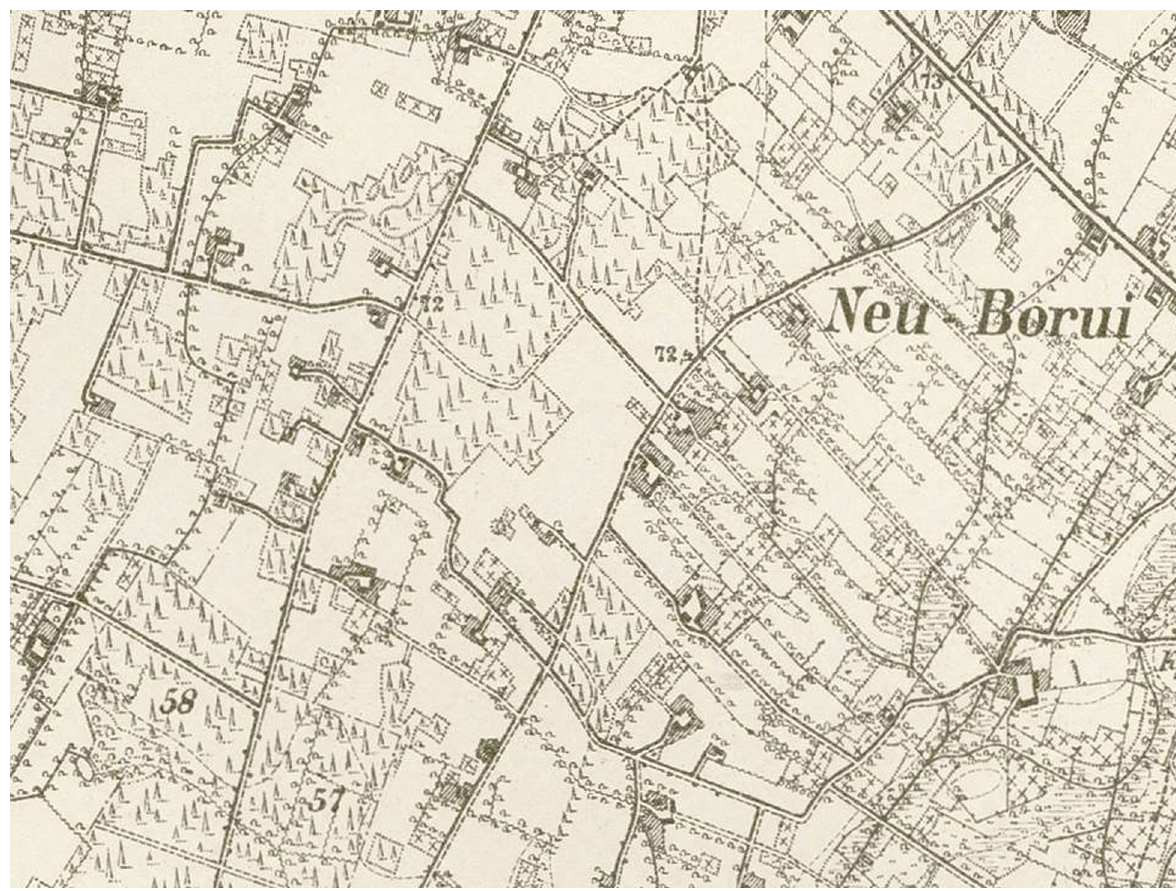
Fig. 3. Solitary village as an example of Dutch law settlement. source: Messtichblätter, 3762